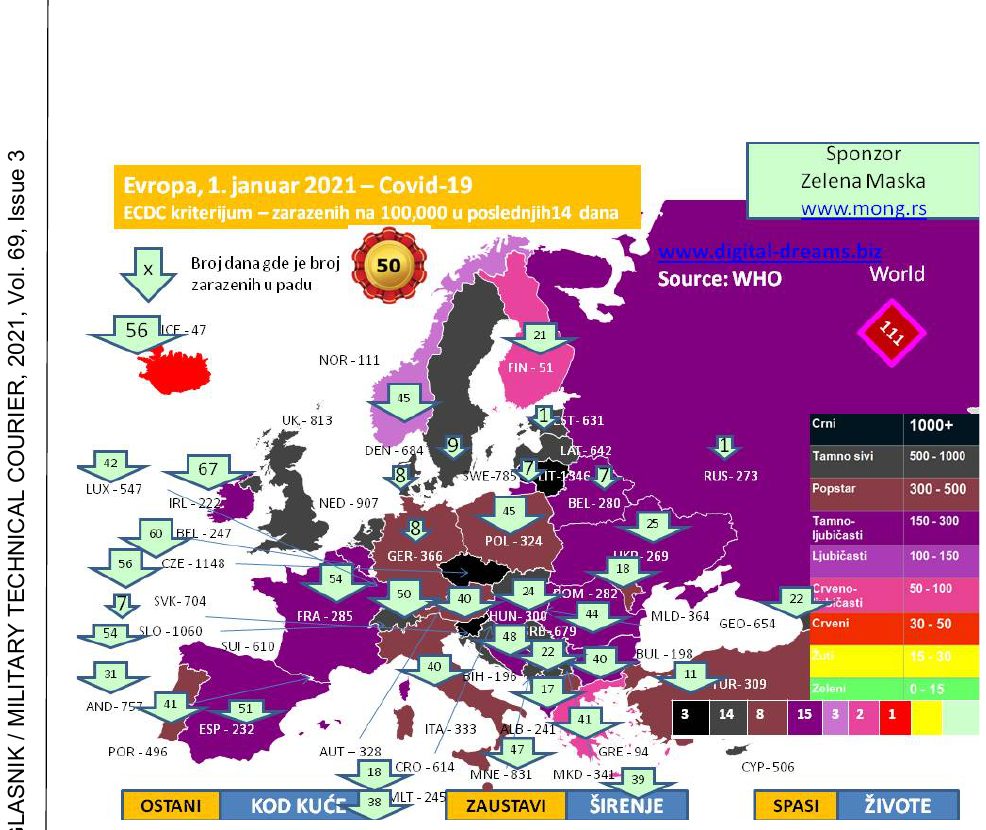
Figure 10 – ECDC coefficients for European countries on January 1, 2021. Compare this figure with Figure